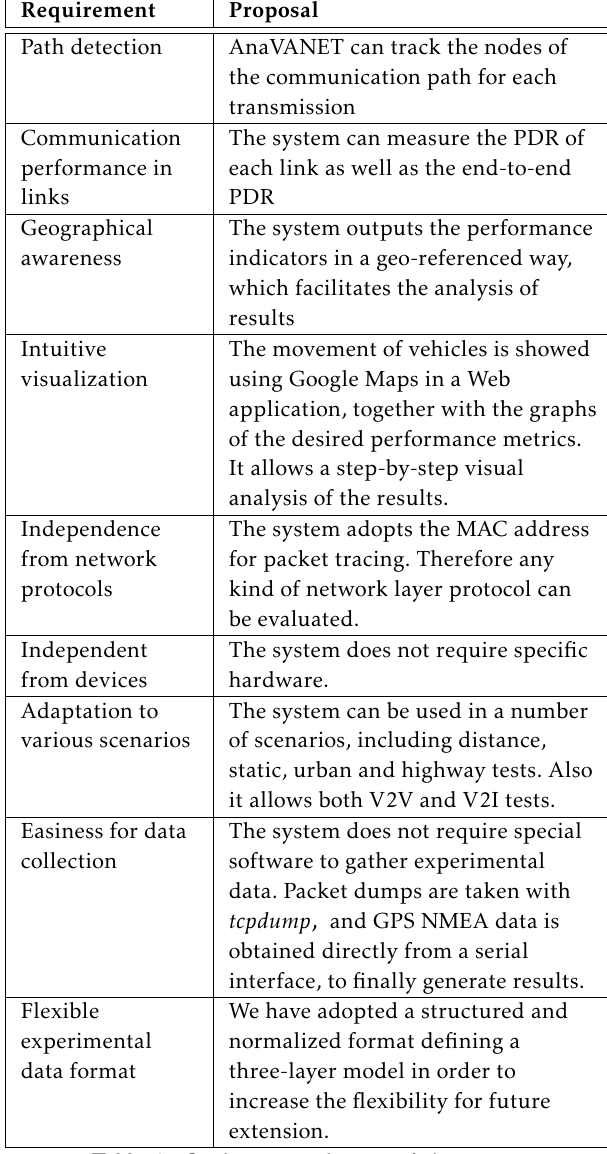
Table 1. Qualitative evaluation of the